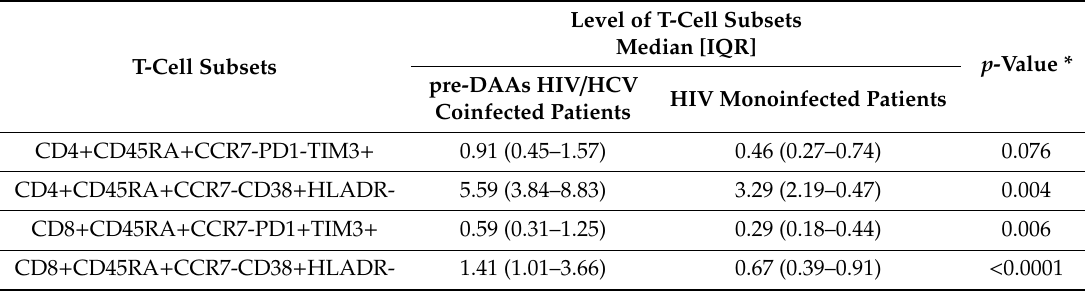
Table 2. Levels of different T-cell subsets in HIV/HCV coinfected patients before DAAs treatment (pre-DAAs) compared to HIV monoinfected patients.